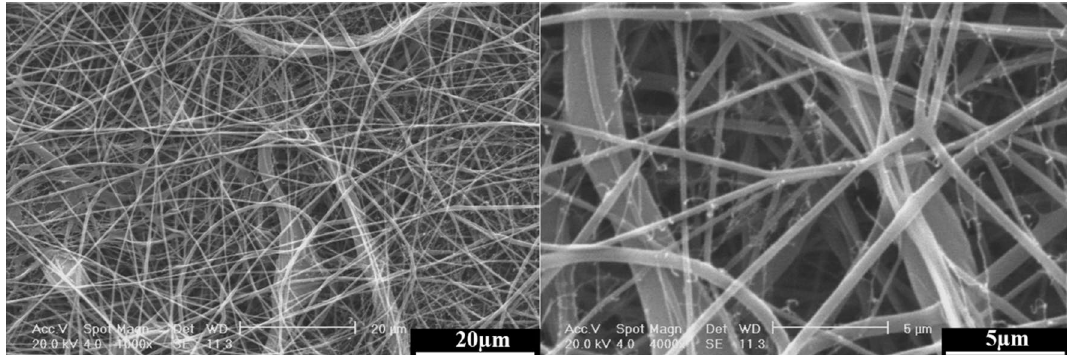
Figure 7. SEM images of the PCL-50HAMP scaffold, at different magnifications.